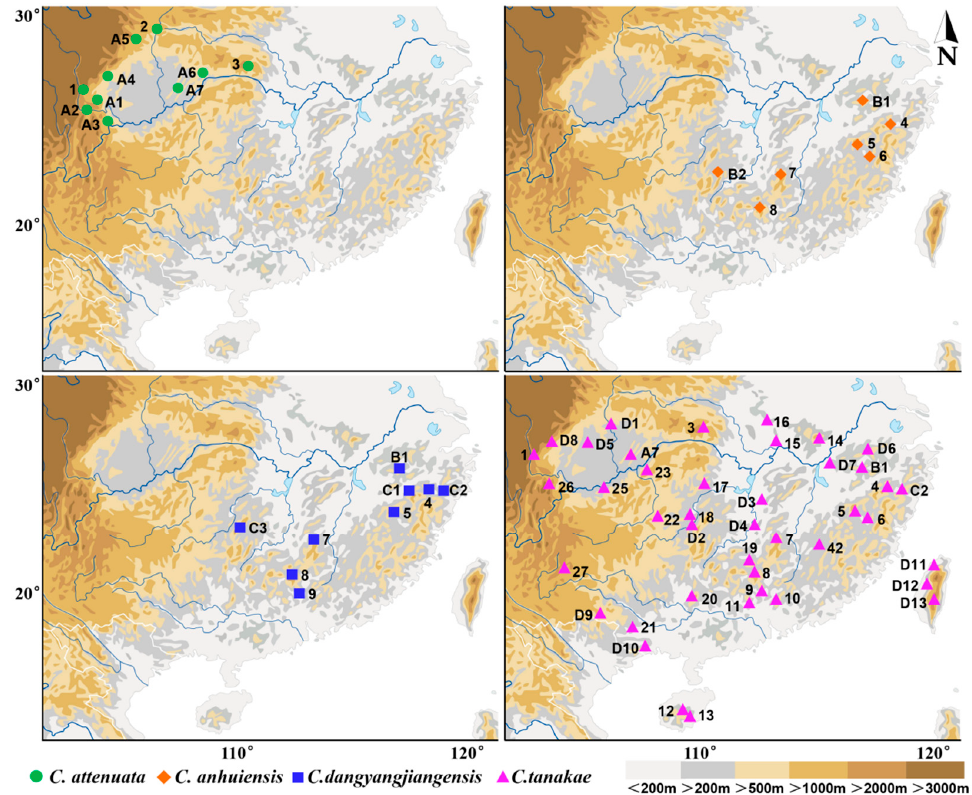
Figure 1. Specimen locality of Crocidura attenuata species complex in China.